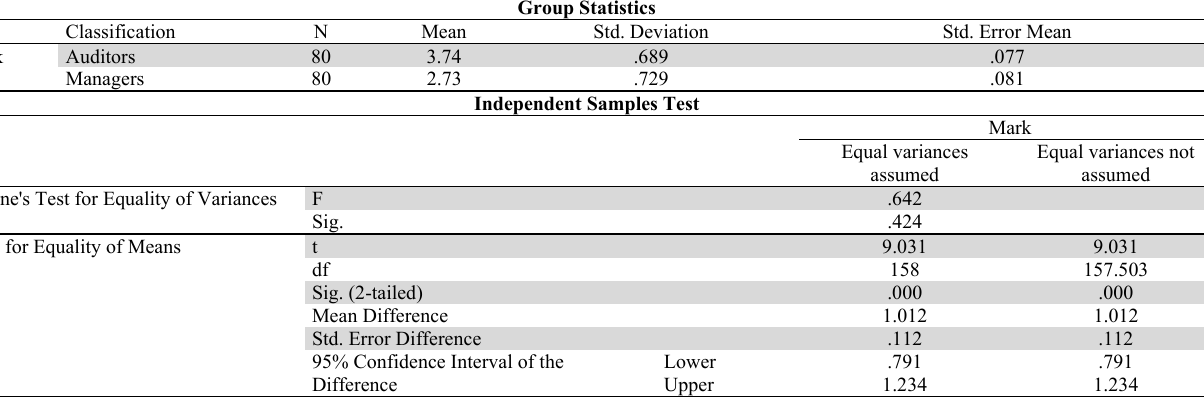
Evaluation of the impact of the benefits and costs on the application of the international financial reporting standards for SMEs from the perspectives of auditors and